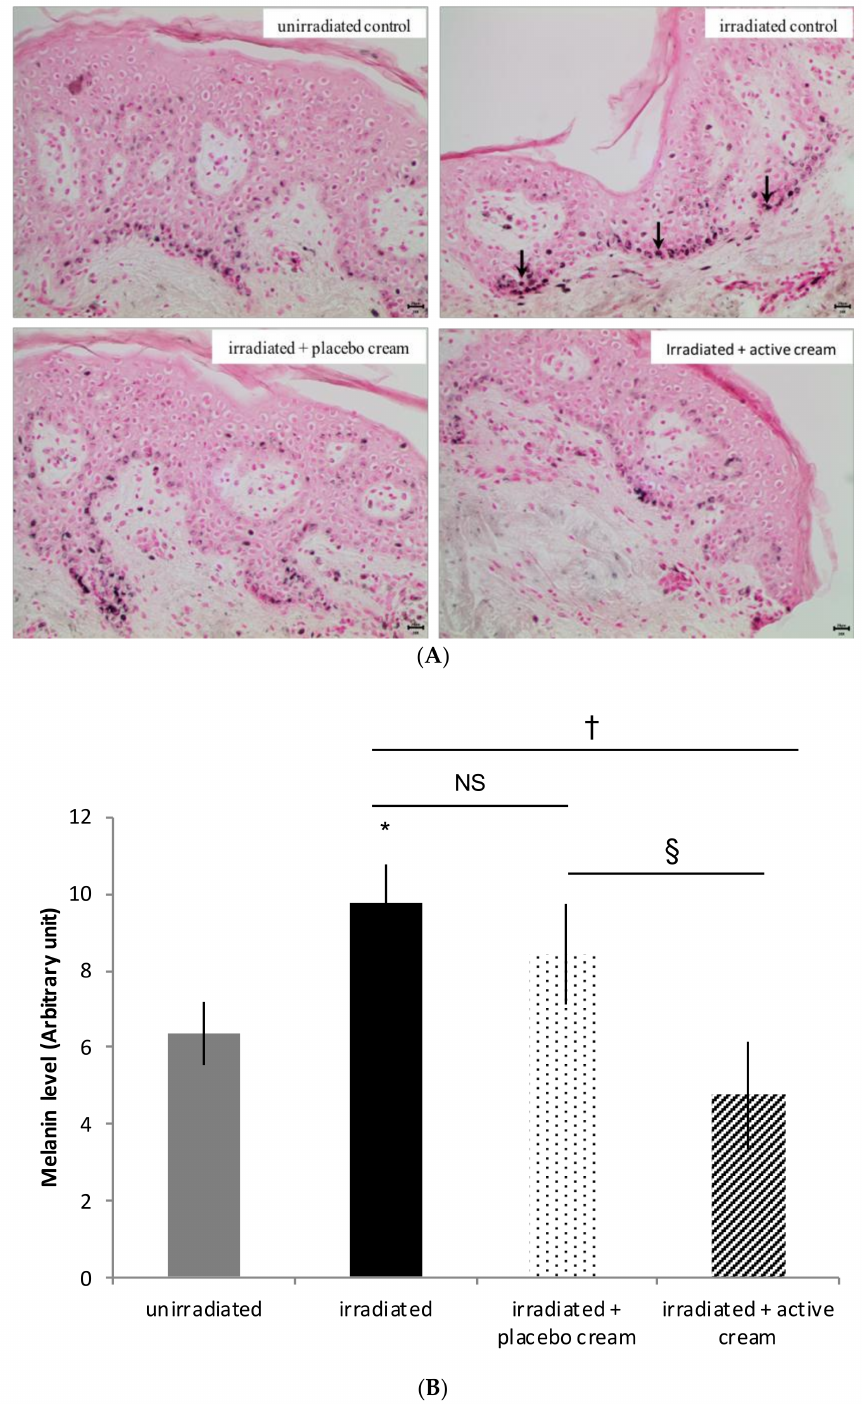
Figure 5. Influence of melon concentrate application on the melanin level after irradiation of human skin explants. ( A ) Fontana Masson histochemical staining of human skin explants for melanin observation. Arrows show melanin; ( B ) Melanin level determined after histochemistry analysis on at least 30 transverse sections per skin explant. Relative levels were presented in arbitrary units as mean ± SEM. * p < 0.05 compared with unirradiated skin explants, † p < 0.05 compared with irradiated skin explants, § < 0.05 effect of melon concentrate treatment compared with the irradiated + placebo cream group. NS: